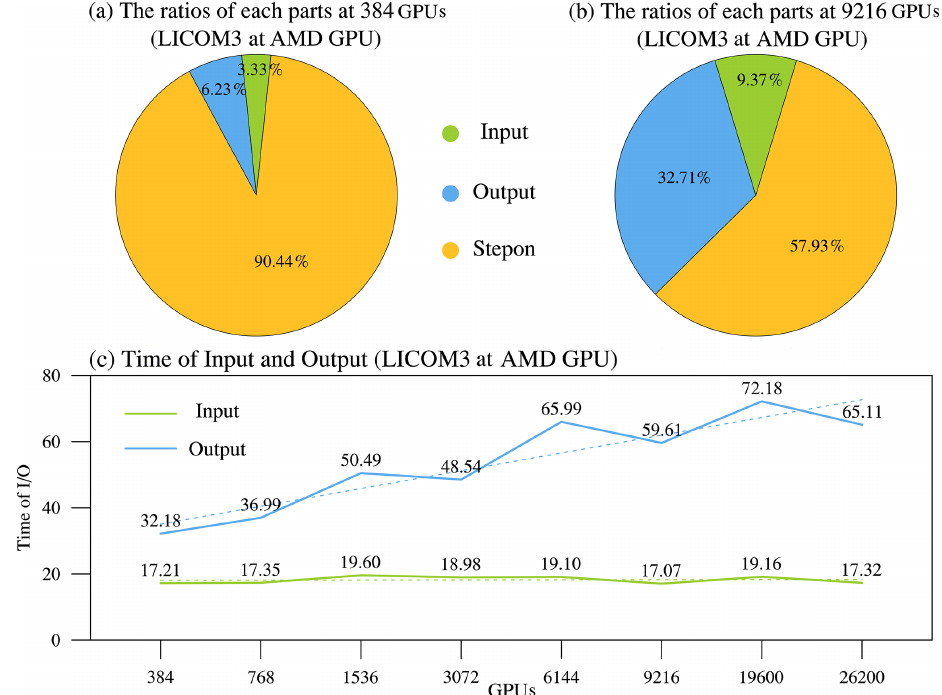
Figure 8. (a) The 384GPUs and (b) 9216GPUs, with the I / O ratio in total simulation time for the 1 / 20 ◦ setup, and (c) the changes in I / O times vs. different GPUs.